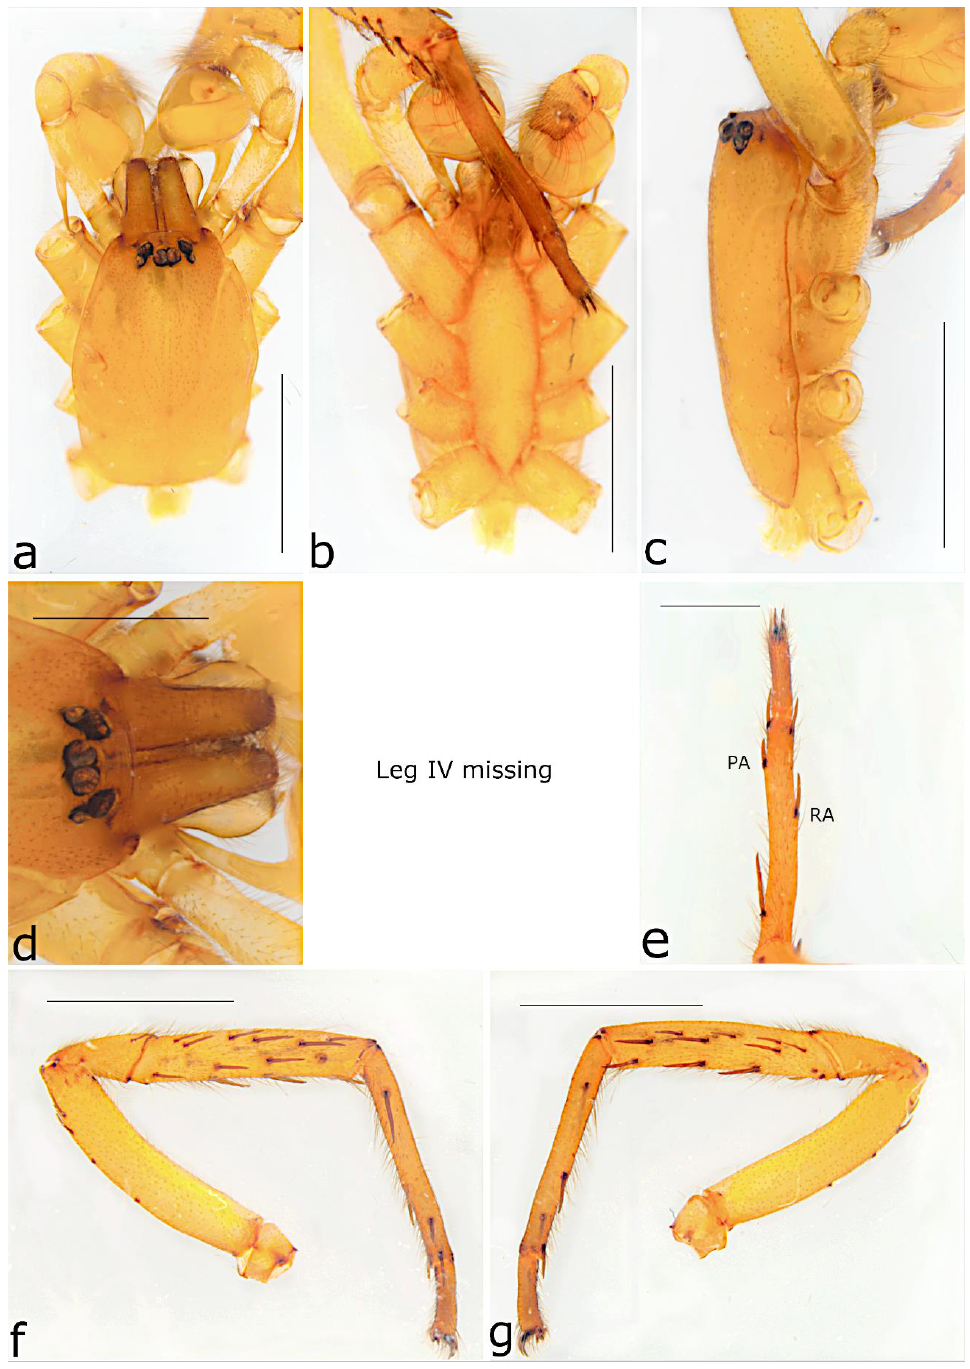
Figure 33. Ariadna deserta sp. nov. ♂ holotype (SAMA NN30493) from Witjira National Park (SA): ( a ) habitus, dorsal view; ( b ) same, ventral view; ( c ) same, lateral view; ( d ) eyes, dorsal view; ( e ) right leg I (mirrored), ventral view; ( f ) same, prolateral view; ( g ) same, retrolateral view. Scale bars ( a – e ) = 1 mm and ( f , g ) = 2 mm. Description. (based on holotype; SAMA NN30493). Total length unknown (ab- domen ♂